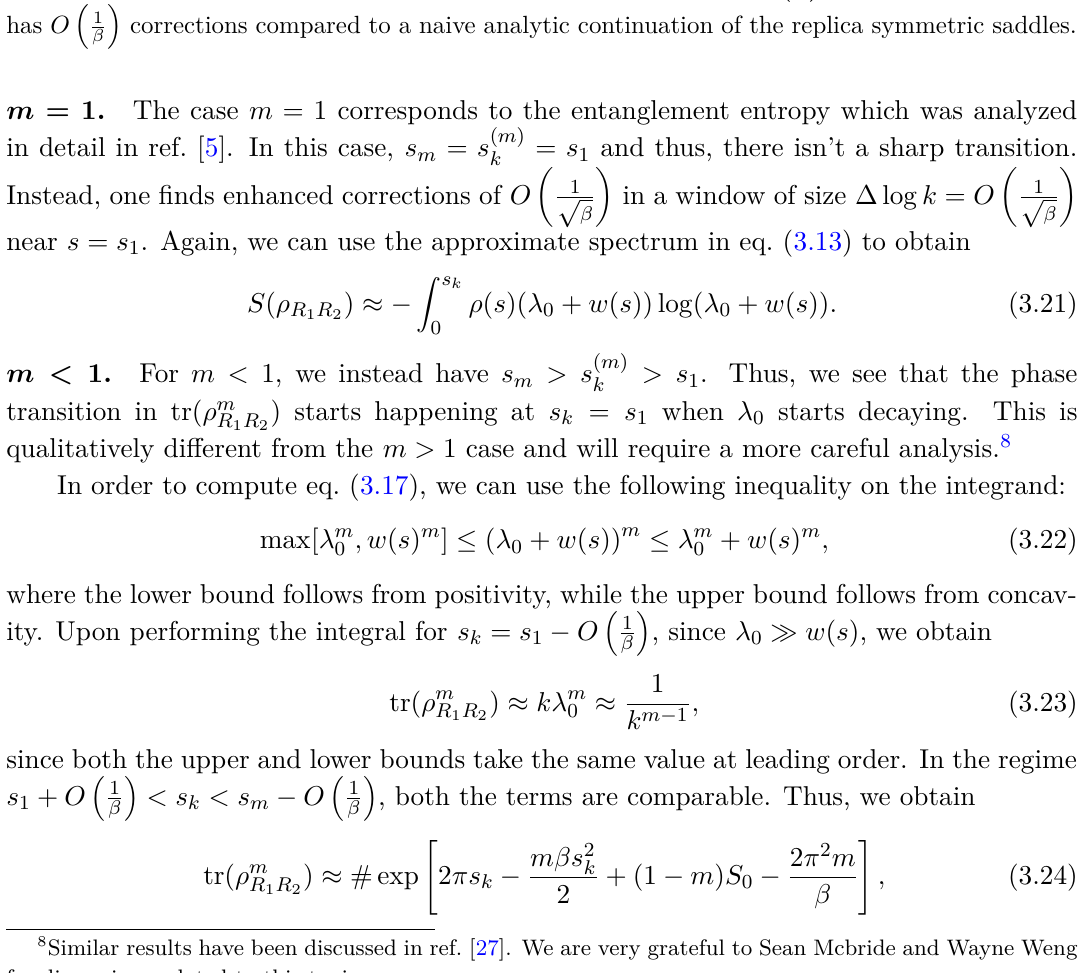
(cid:16) (cid:17) 1 and the Renyi entropy β